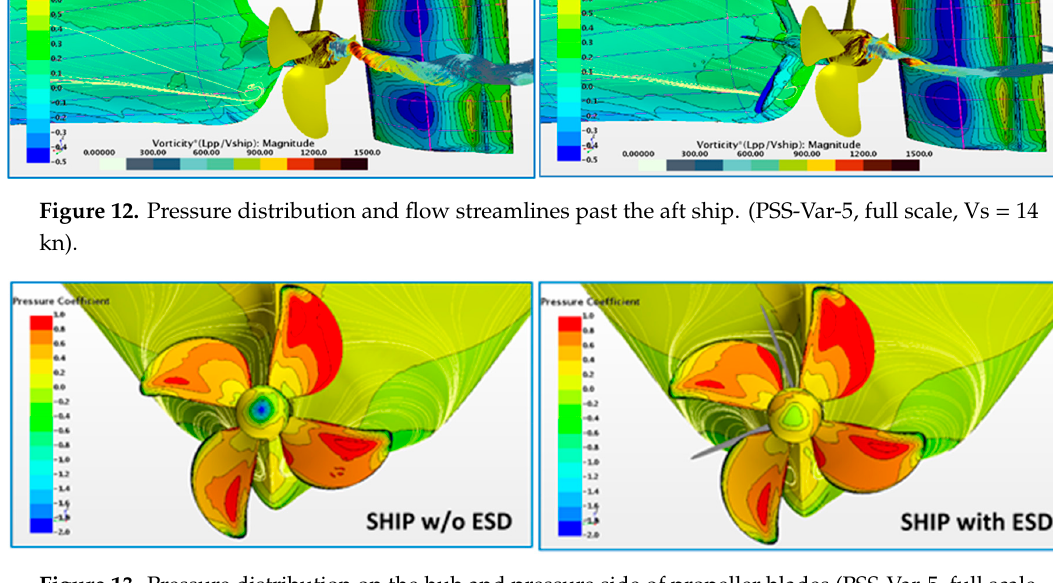
Figure 13. Pressure distribution on the hub and pressure side of propeller blades (PSS-Var-5, full scale, Vs = 14 kn).